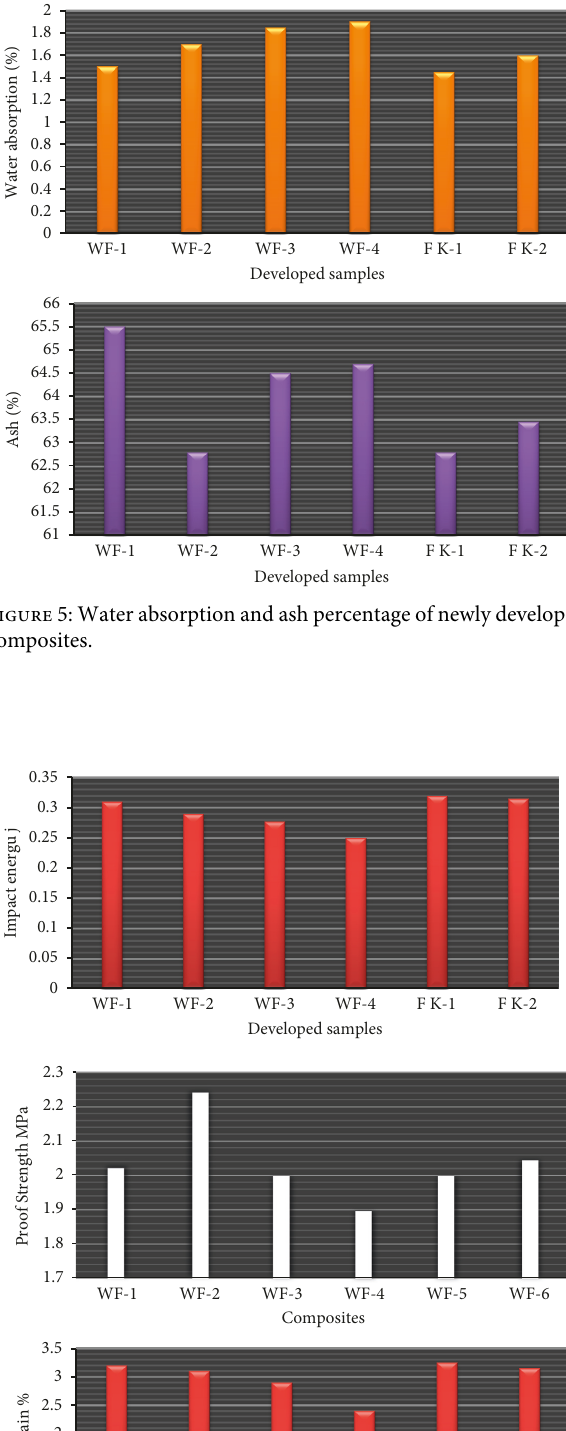
Figure 4: Density and hardness of newly developed composites.